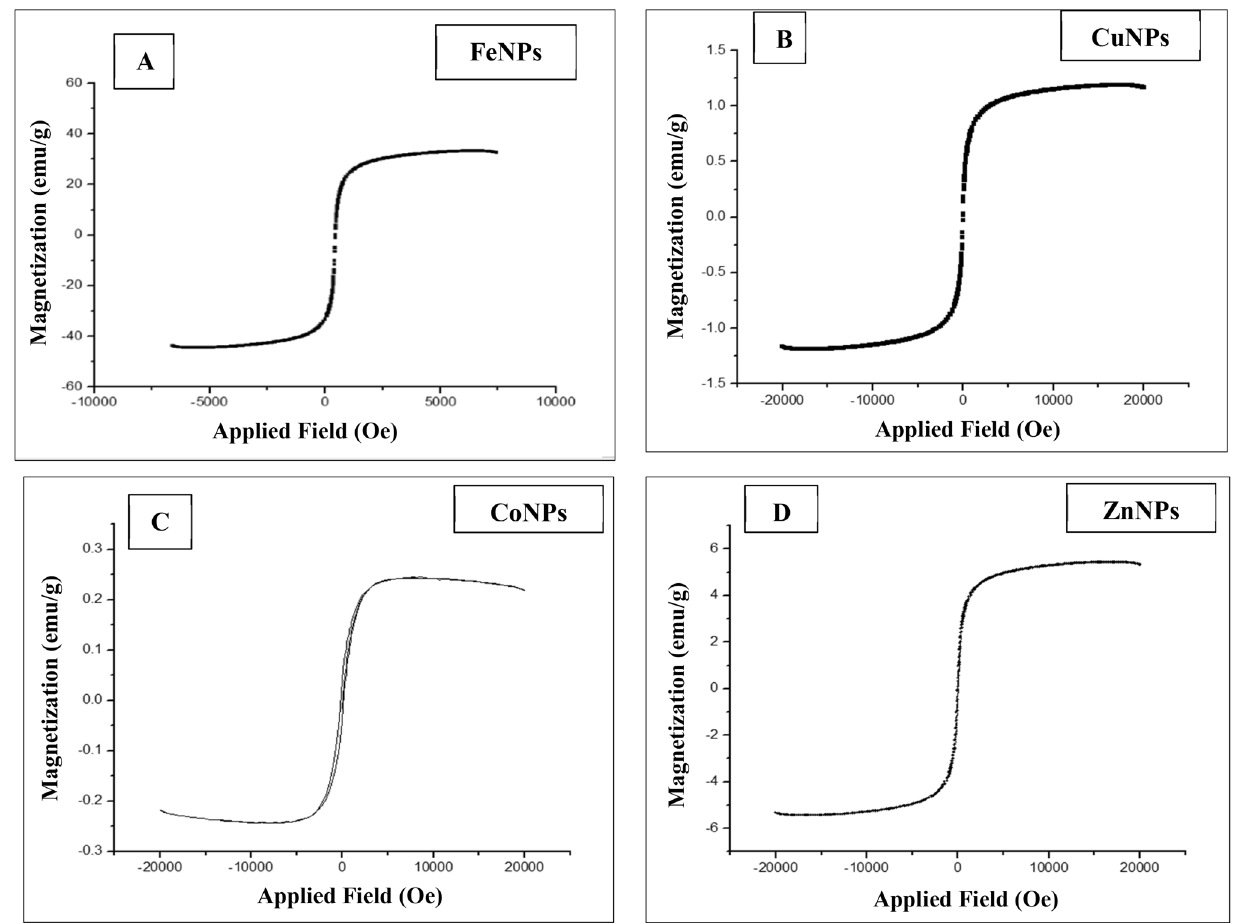
Figure 10. Room temperature magnetization curves of FeNPs ( A ), CuNPs ( B ), CoNPs ( C ) and ZnNPs ( D